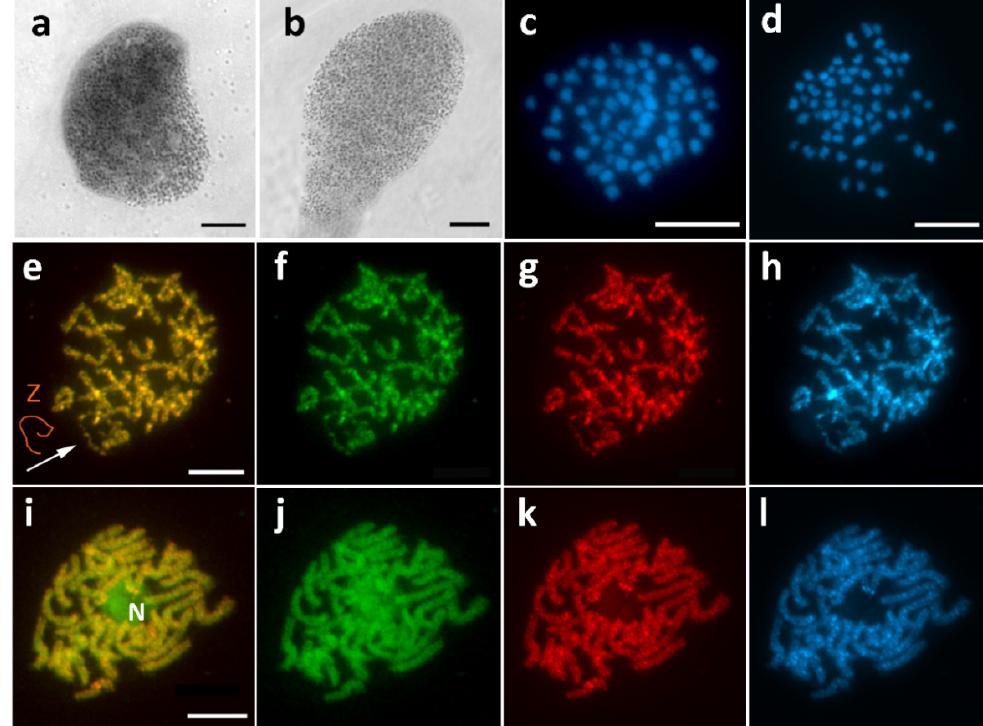
Figure 2. Missing W chromosome in Aethalura punctulata . Sex chromatin was absent in female ( a ) and male ( b ) polyploid nuclei stained with orcein. Mitotic metaphase chromosomes stained with DAPI show 2 n = 61 in females ( c ) and 2 n = 62 in males ( d ). Comparative genomic hybridization (CGH) on female pachytene chromosomes ( e – h ) did not reveal any differentiated chromosome. The Z univalent is indicated by an arrow and shown in the scheme ( e ). CGH on male pachytene chromosomes showed similar results, but no univalent was found ( i – l ); note nucleolus (N). Panels ( e , i )—merged pictures of both probes; ( f , j )—female genomic probe (green); ( g , k )—male genomic probe (red); ( h , l )—DAPI staining (light blue). Bar = 10 µm.